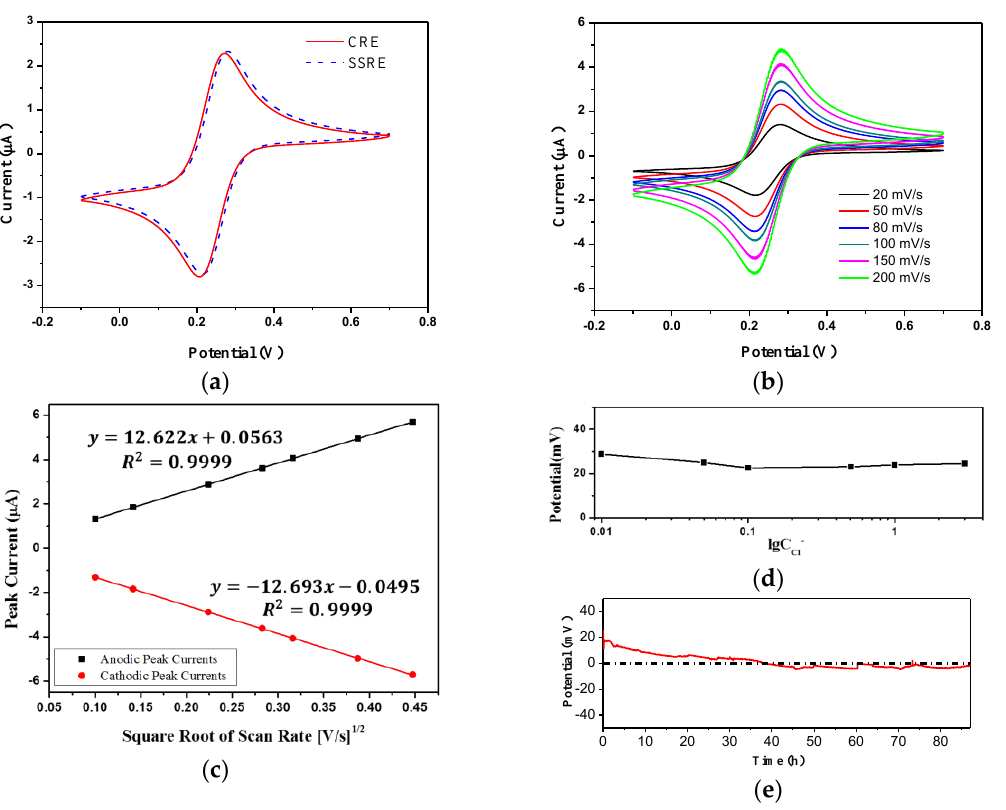
Figure 6. Electrochemical characteristics of the SSRE: ( a ) CVs for SSRE (----) and CRE ( — ) in 2 mM ferricyanide at 50 mV/s; ( b ) CVs for SSRE at various scan rates: 20, 50, 80, 100, 150, and 200 mV/s; ( c ) variations of the anodic ( ■ ) and cathodic (●) peak currents vs. the square root of the scan rates; ( d ) potentials of the SSRE at KCl concentrations ranging from 0 to 3 mol/L; and ( e ) the stability of the SSRE measured in deionized water over 86 h. Table 1. Comparison of the performance of some solid-state reference electrodes for pH sensing.